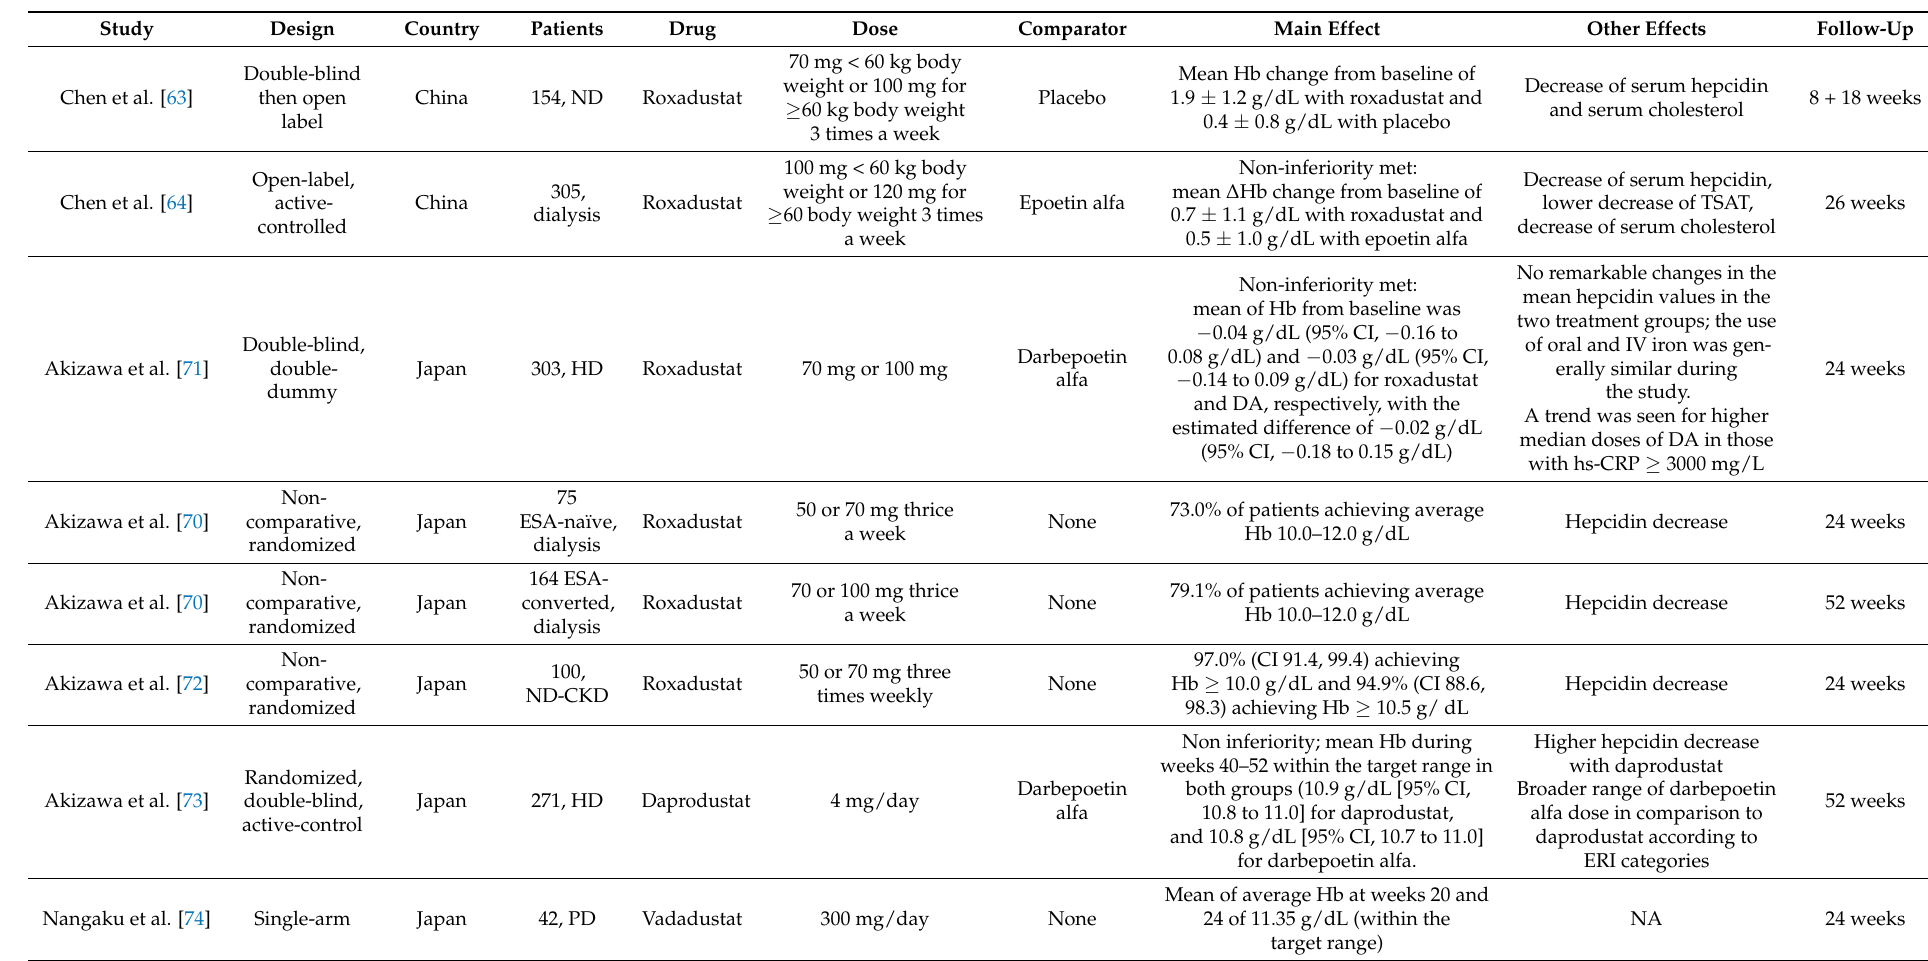
Table 1. Phase-III clinical studies of PHD inhibitors published as full